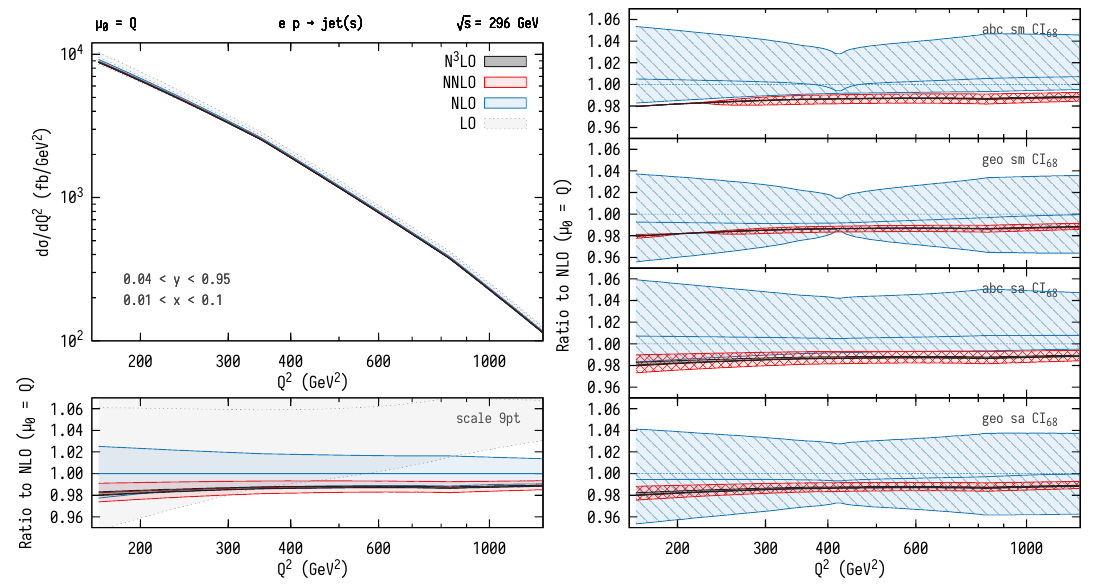
Figure 18 . Deep inelastic scattering distribution dσ/dQ 2 up to N 3 LO with µ 0 = Q as the cen- tral scale choice. Left: absolute distributions and 9-point scale variation envelopes normalised to the NLO prediction at µ . Right: 68% CIs for the abc and geometric models using the scale- 0 marginalisation (top) and scale-averaging (bottom) prescriptions (also normalised to